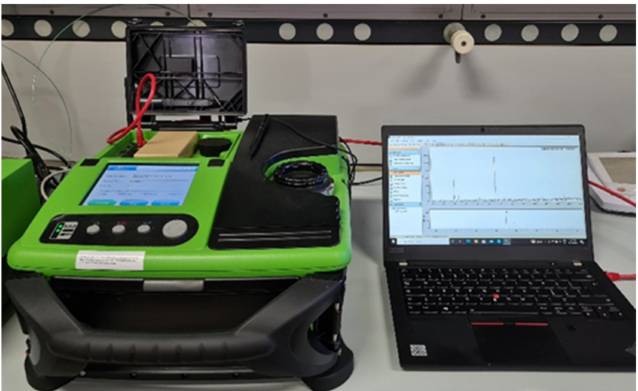
Figure 4. The portable GC-MS Torion ® T-9 interfaced with its